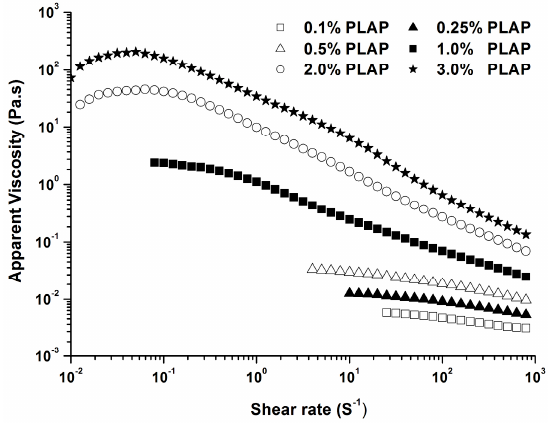
Figure 1. Effect of polysaccharide concentration on apparent viscosity of PLAP at 25 °C.